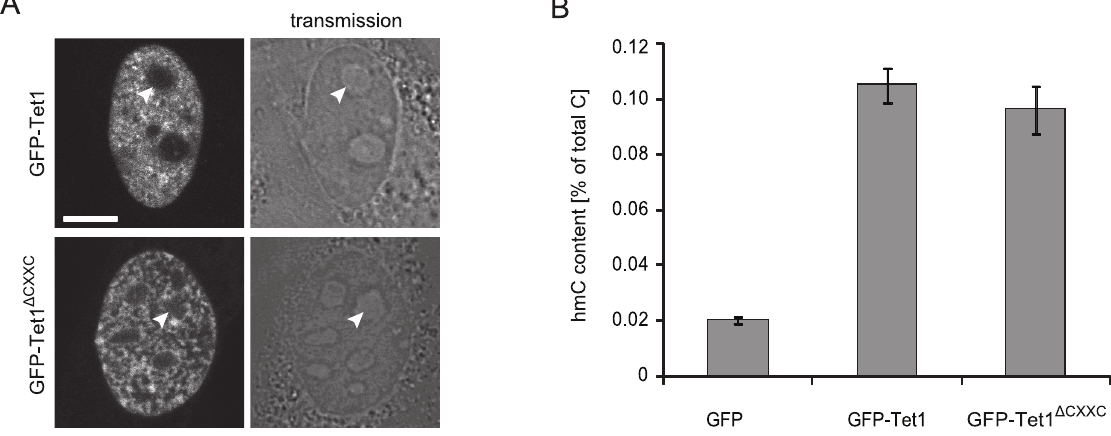
Figure 3. Cellular localization and invivo catalytic activity of GFP-Tet1 and GFP-Tet1 D CXXC . (A) Live images of C2C12 myoblasts expressing GFP-Tet1. Scale bar: 5 m m. (B) Genomic hmC content in HEK293T cells overexpressing GFP, GFP-Tet1 and GFP-Tet1 D CXXC . Shown are mean values and standard deviation of hmC percentage over total cytosine for three measurements from one transfection.